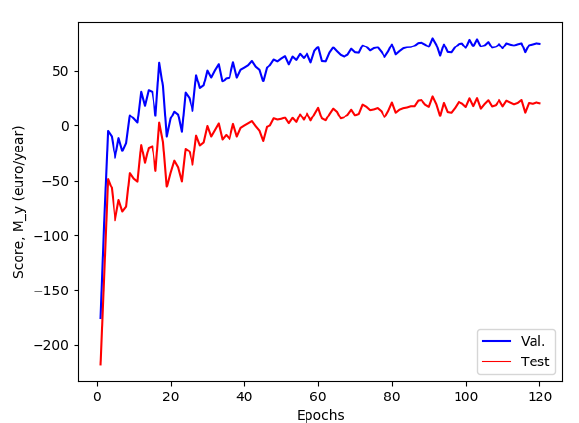
Fig. 18. Operational revenue 𝑀 𝑦 for the Case